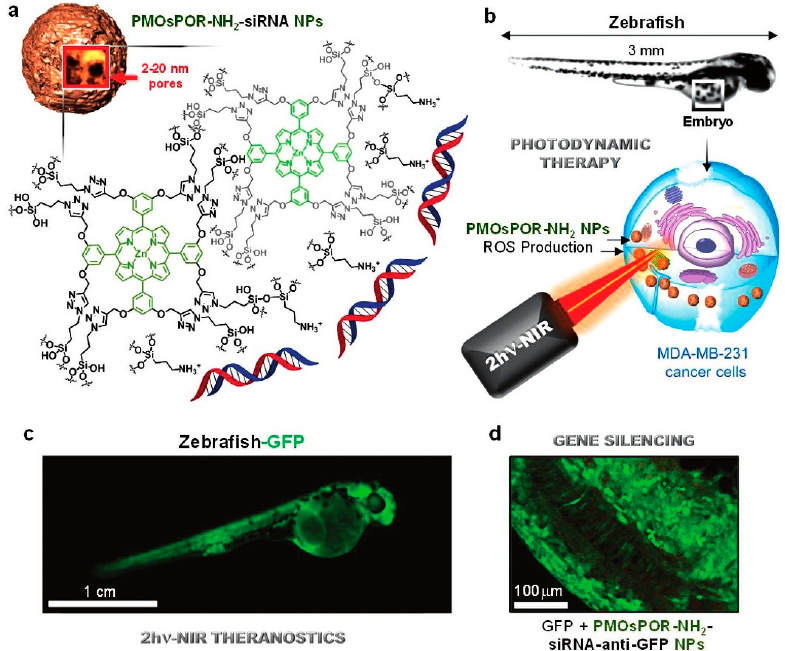
Figure 11. ( a ) Amine functionalized porphyrin-based mesoporous organosilica nanoparticles (PMOsPOR-NH 2 ) for siRNA binding; ( b ) Two-photon excited near-infrared (TPE-NIR) photodynamic therapy on zebrafish via PMOsPOR-NH 2 ; ( c ) TPE-NIR gene silencing on zebra fish-GFP via PMOsPOR-NH 2 -siRNA; ( d ) Bioimaging of zebrafish embryos after gene silencing. Reproduced from [61], with permission from John Wiley and Sons.